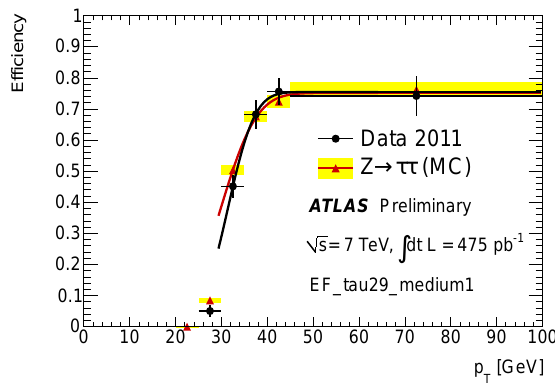
Fig. 4. Tau trigger e ffi ciency measured in Z → ττ decays us- ing 2011 data by applying a tag-and-probe method for the EF tau 29 medium . The e ffi cieny is measured w.r.t. o ffl ine tau can- didates passing medium identification requirements as a function of the o ffl ine tau p T